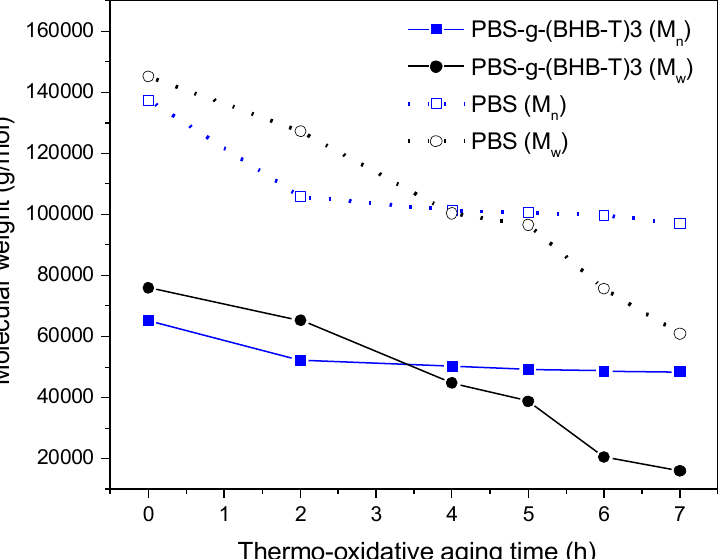
Figure 3. Number- and weight-average molecular weight of PBS and PBS-g-(BHB-T)3 as a function of thermo-oxidative aging time.